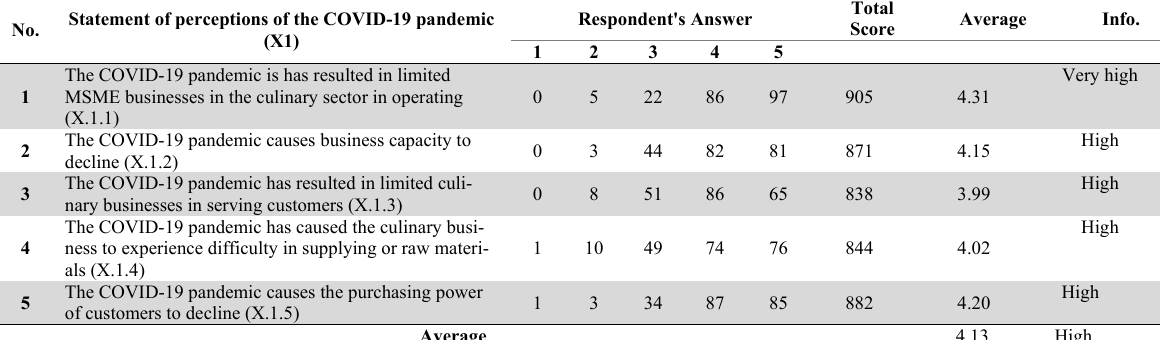
Description of Respondents' Answers Regarding Assessment of the Variable Perception of the COVID-19 pandemic